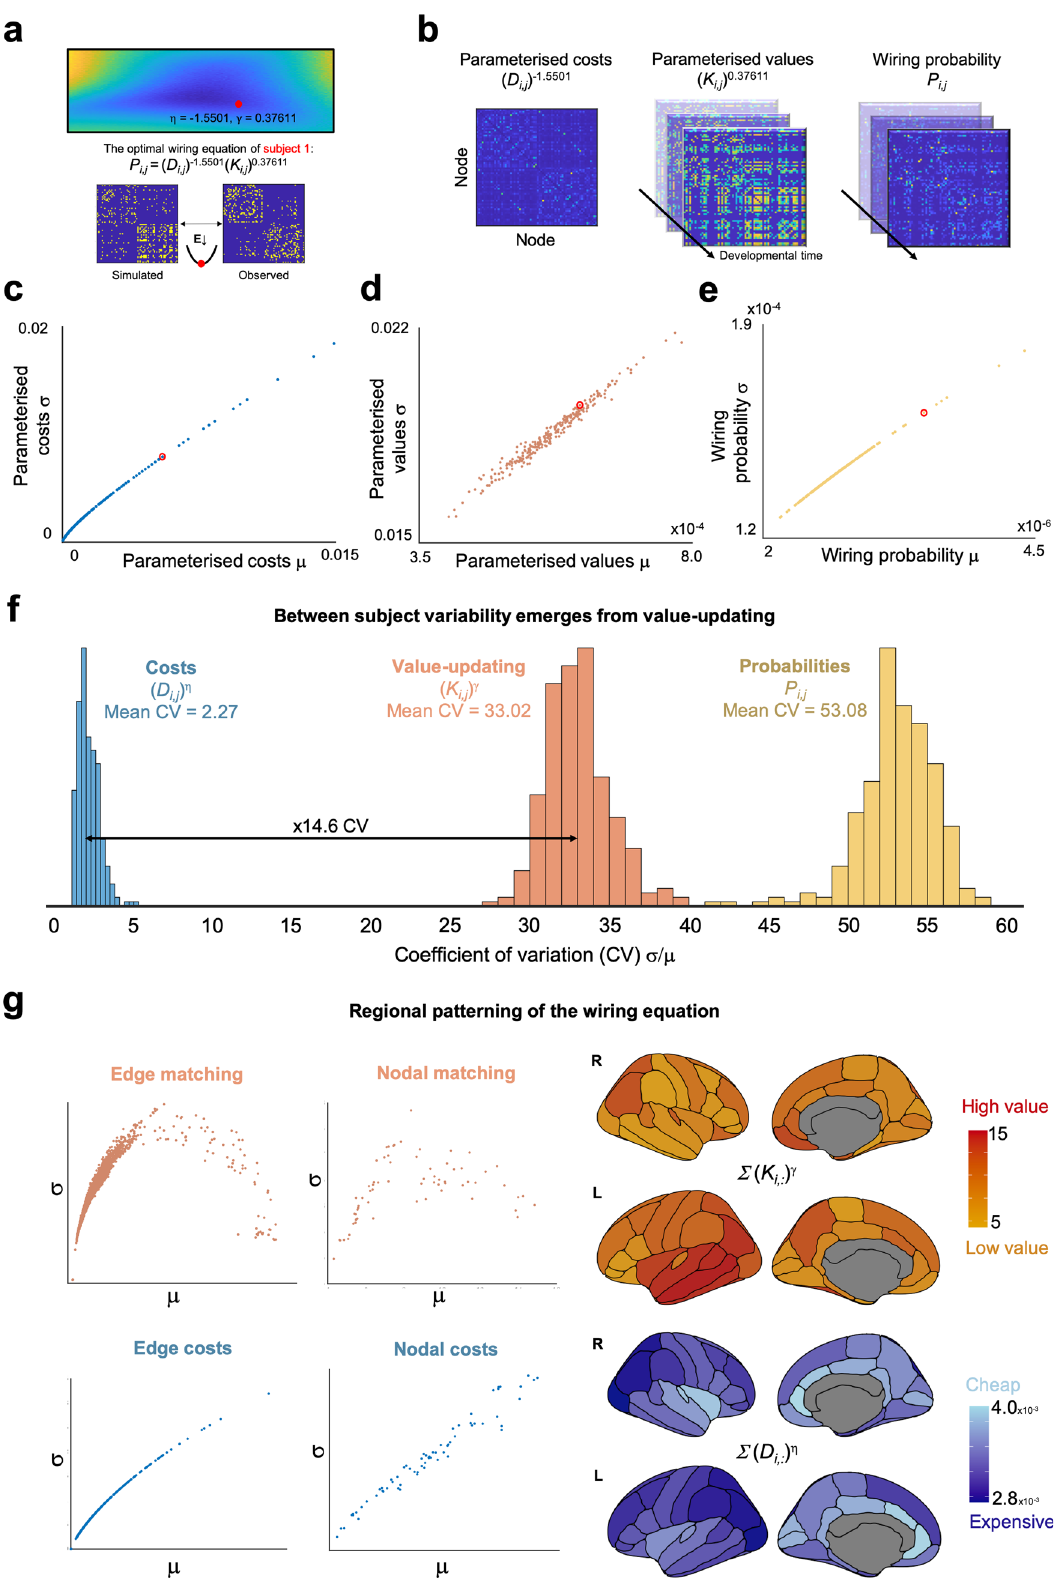
the matching value is dynamic, changing at each iteration (as in Fig. 1d), unlike relative Euclidean distance between nodes which is static. The result is that signi fi cant inter-individual variability arises in the probability of connections forming (mean CV